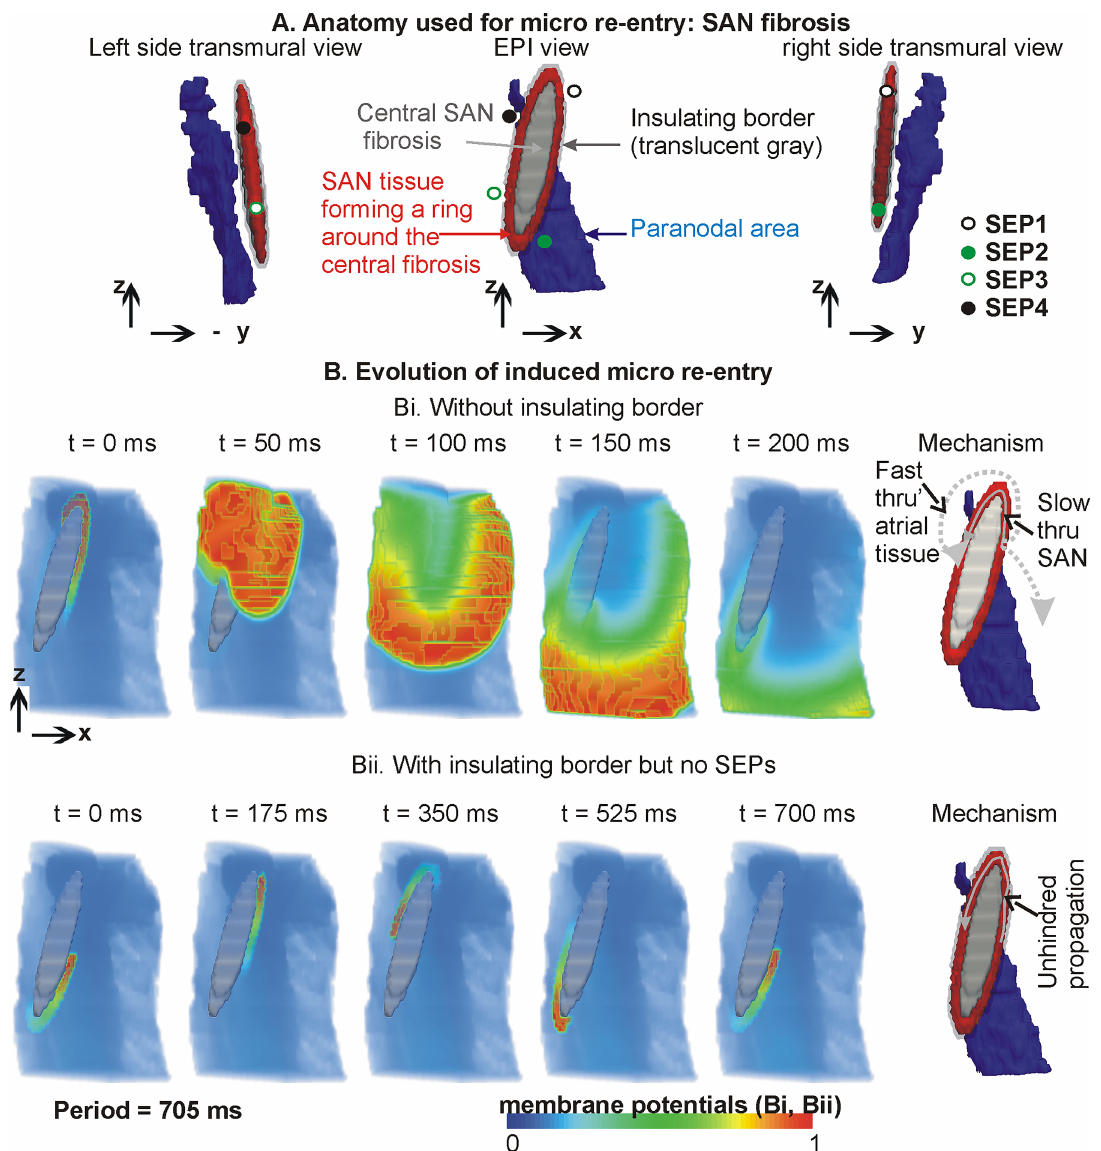
Fig 4. SAN micro re-entry without SEPs. A: Epicardialas well as transmural views of SAN (red), paranodalarea (blue), and non-conducting intra-SAN fibrosis (gray). The morphology of the fibrosis is further illustrated by the transmural left and right views. Locationsof the omitted SEPs are shown by circular symbols to provide further anatomicallandmarks. B: Evolutionof micro re-entry. Top row (Bi) shows data from simulationwithout insulatingborder. Bottom row (Bii) shows data from simulation with insulatingborder without SEPs. Bi data show dissipationof re-entry due to absence of insulatingborder. Sixth panel illustratesthe mechanism. Bii shows data with the insulating border configuration where the re-entry persistedunhindered. Sixth panel illustrates the